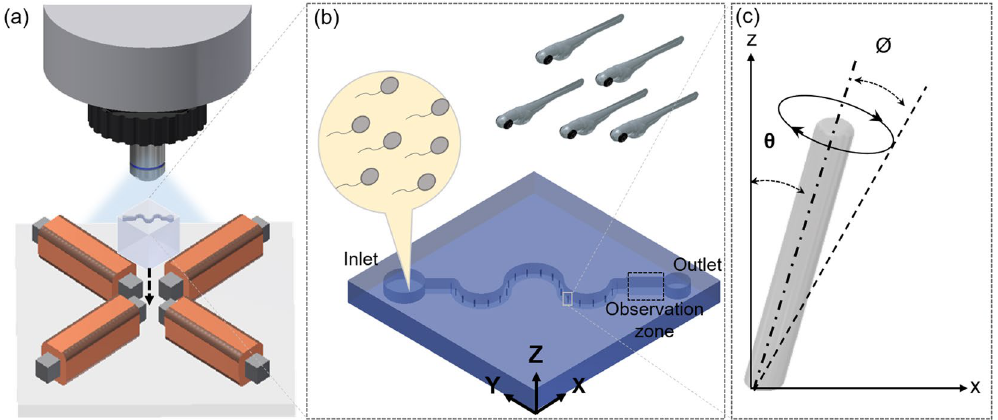
Figure 2. ( a ) A magnetic actuation system which consists of four electromagnetic coils to control motions of artificial cilia inside a microfluidic platform. ( b ) Schematic illustration of the microchannel, where the observation zone was in the vicinity of the outlet and reserved for the sperm motility analysis. ( c ) The artificial cilia were tilted up to a certain angle due to residual stress generated during the microfabrication procedure. All the artificial cilia were actuated in a circular manner.